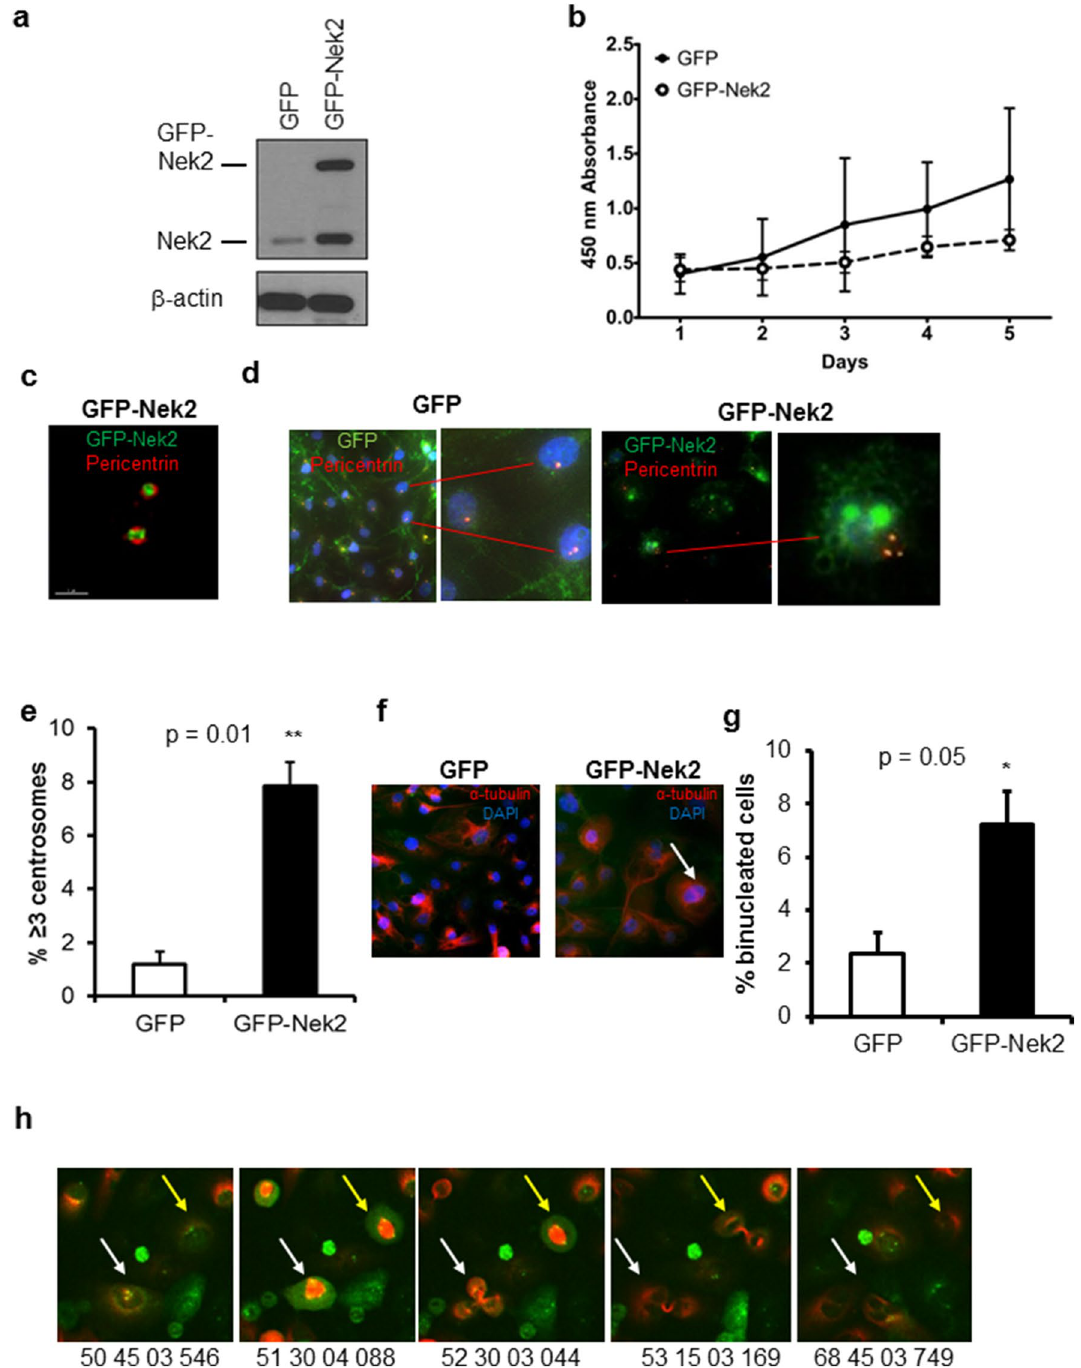
Figure 1. Nek2 overexpression causes centrosome amplification and binucleation. ( a ) Representative immunoblot of MCF10A cells expressing either GFP or GFP-Nek2 indicating overexpression of endogenous Nek2 and GFP-Nek2 detected with Nek2 antibodies. ( b ) CCK8 c ell growth/viability assay comparing MCF10A expressing GFP or GFP-Nek2. ( c ) High-resolution microscopy of a centrosome pair indicating localization of pericentrin (red) and GFP-Nek2 (green). ( d ) Immunofluorescent staining of pericentrin (red) in GFP and GFP-Nek2-expressing cells (green) counterstained with DAPI (blue). The right inset (GFP-Nek2) indicates a cell with 3 centrosomes. ( e ) Quantifications of fluorescent microscopy for centrosome amplification by pericentrin staining. N = 3, bars = mean ± SD, * p < 0.05. ( f ) Immunofluorescent staining of α-tubulin (red) in GFP and GFP- Nek2-expressing cells counterstained with DAPI (blue). The arrow indicates a binucleated cell. ( g ) Quantifications of fluorescent microscopy for binucleation by α-tubulin staining. N = 3, bars = mean ± SD, * p < 0.05. ( h ) Representative screenshots of MCF10A/GFP-Nek2 cells subjected to live imaging for 72 h. Centrosome-localized GFP-Nek2 is visible in green and the microtubules are marked by RFP-α-tubulin. Arrows indicate tripolar cell division at different time